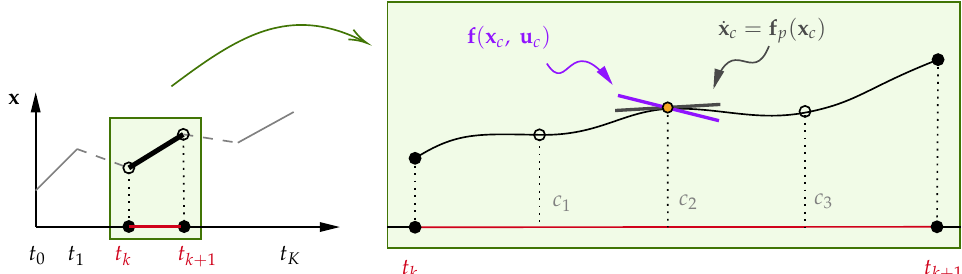
Figure 2. Illustration of collocation points for a time